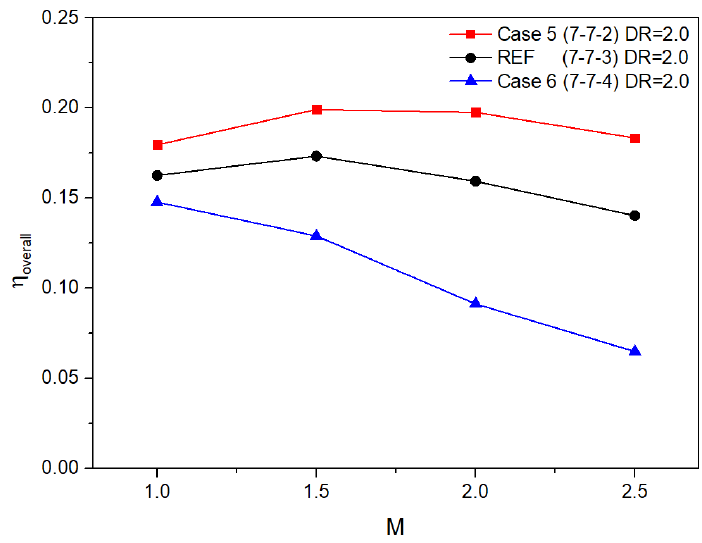
Figure 9. Overall averaged FCE for 7-7-X cases.